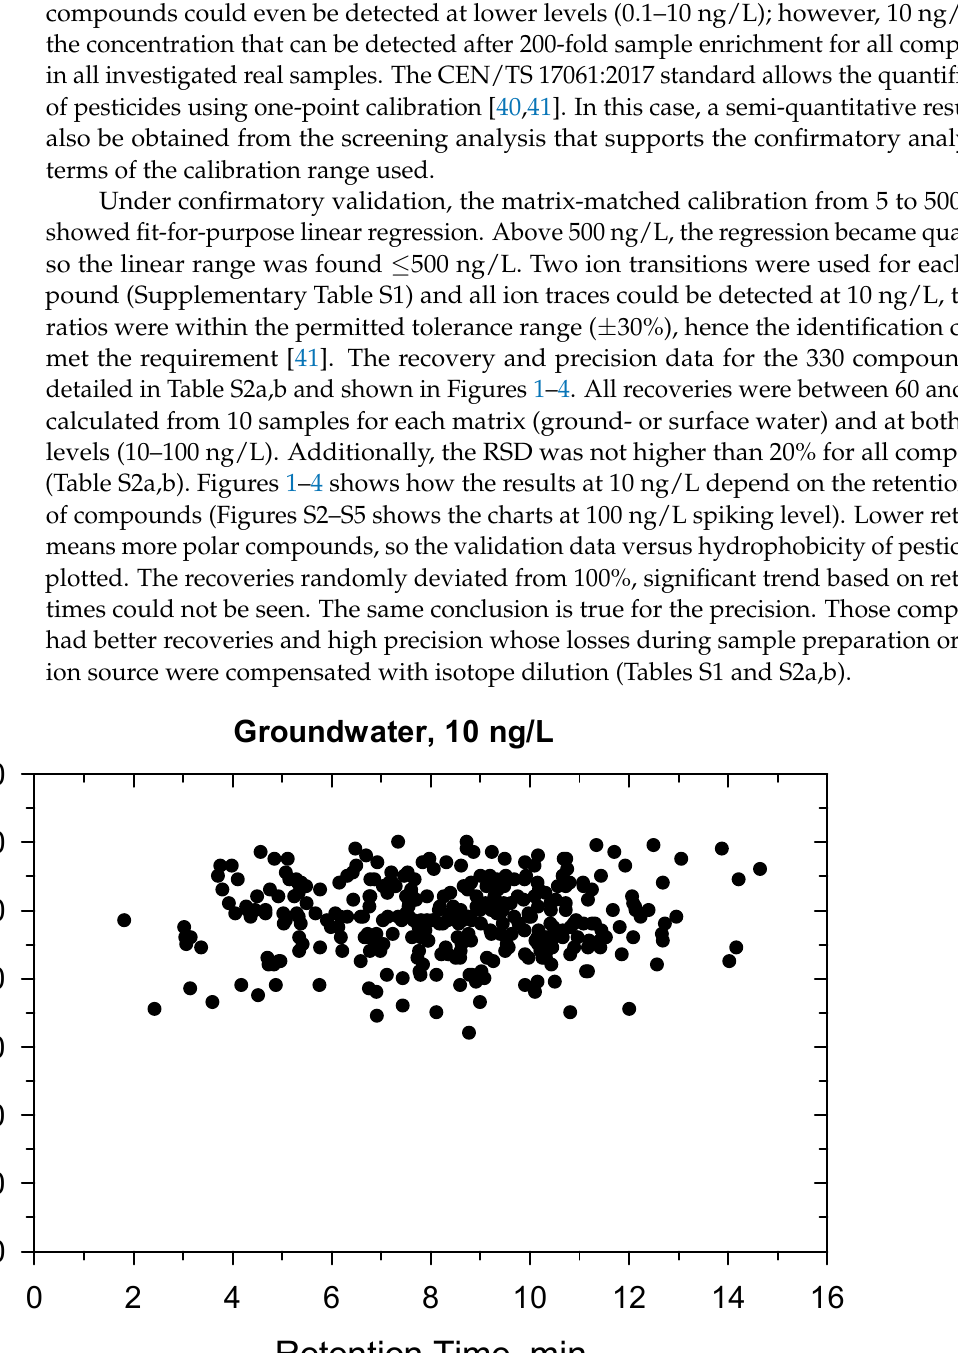
Figure 2. Precision (%) versus retention time (min) at 10 ng/L in groundwater.